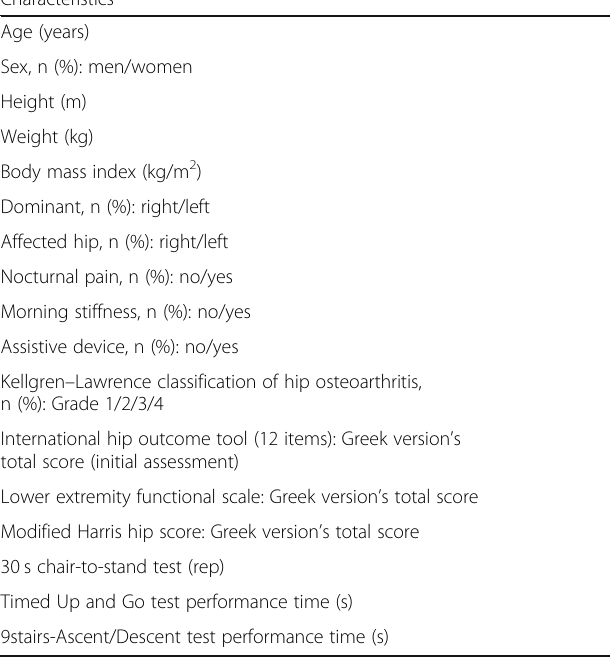
Table 1 Demographic and clinical characteristics of the study ’ s participants ( n = 124)